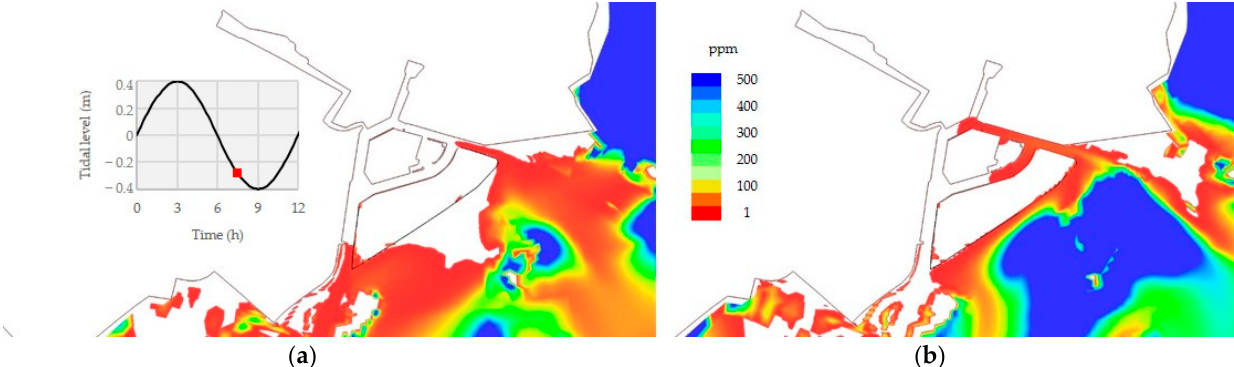
Figure 11. Contour of the maximum suspended sediment concentration during the ebb tide: ( a ) Bora simulation; ( b ) Sirocco simulation.